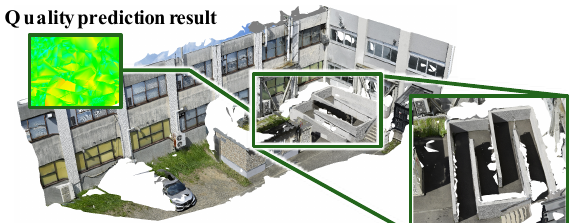
Figure 6. Final dense model and the geometry degradation indicator distribution (a color map on the top-left) on the approximated mesh model after 27 images are added.